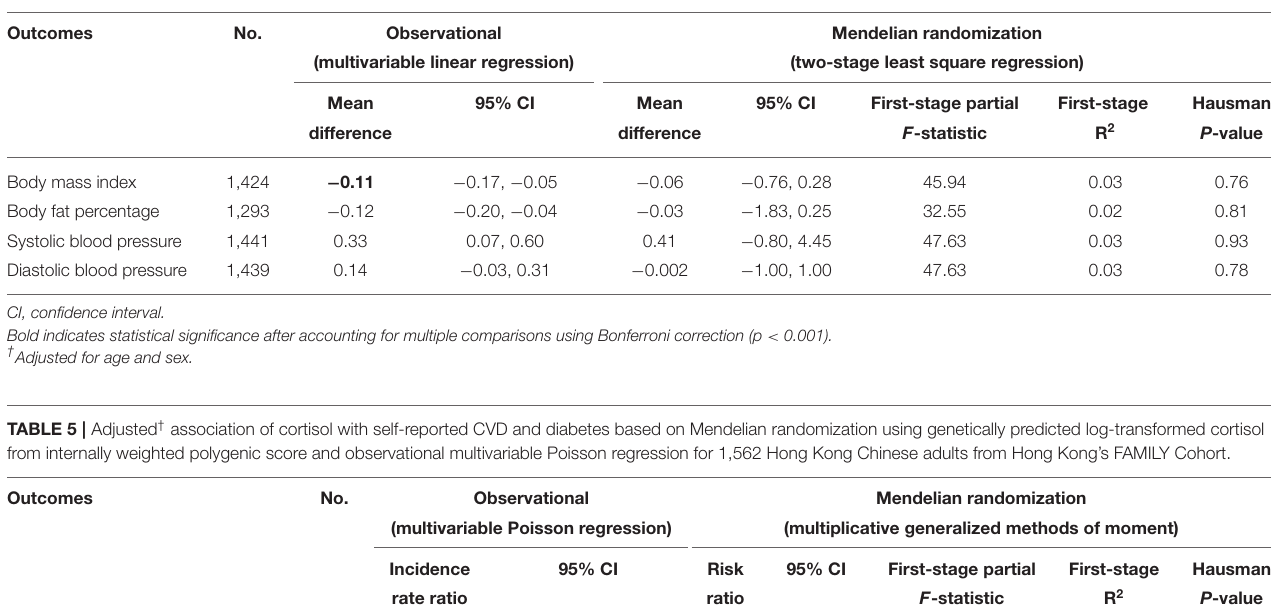
TABLE 4 | Adjusted † association of cortisol with CVD risk factors (BMI, body fat percentage, and systolic and diastolic blood pressure) based on Mendelian randomization using genetically predicted log-transformed cortisol from internally weighted polygenic score and observational multivariable linear regression for 1,562 Hong Kong Chinese adults from Hong Kong’s FAMILY Cohort.